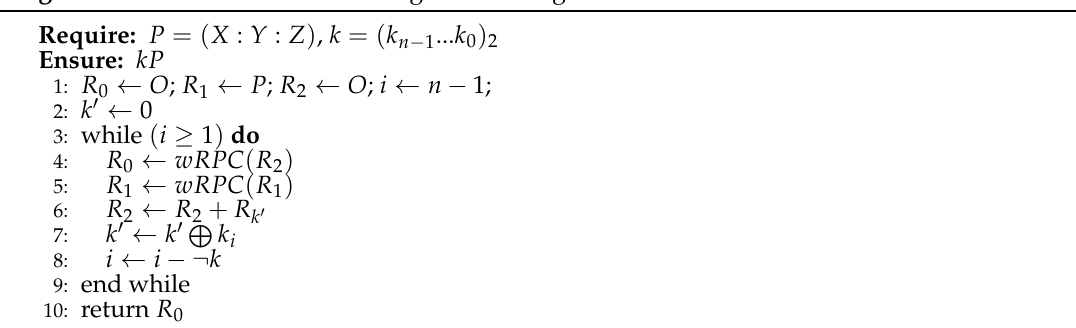
Algorithm 2: Side-channel atomic algorithm using w